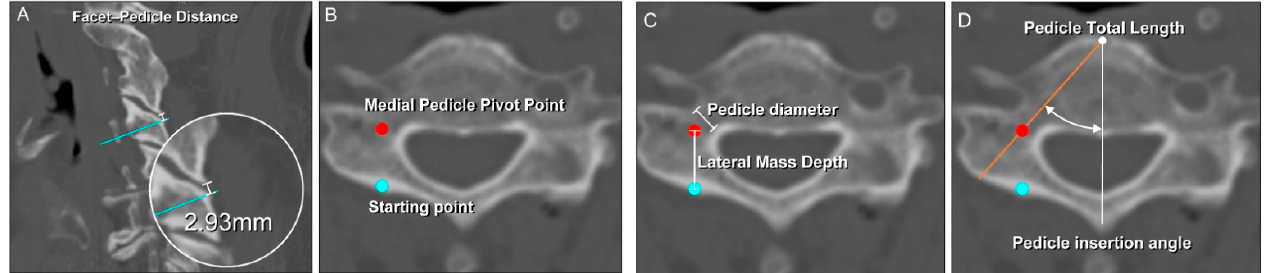
Figure 1. Sagittal and axial computed tomography images of the cervical spine illustrating the morphometric measurements and medial pedicle pivot point (MPPP). ( A ) The facet–pedicle distance was measured from the tip of the inferior articular process of the cephalad vertebra, to a point intersecting a line drawn through the center of the pedicle in the sagittal view (light blue line). ( B ) The red circle indicates the MPPP located at the correct point/center of the pedicle. The light blue circle indicates the starting point. ( C ) Pedicle diameter was measured as shown. The lateral mass depth was measured from the starting point at the dorsal border of the lateral mass, to the MPPP. ( D ) The pedicle insertion angle corresponded with the vertical angle of screw application, while the pedicle total length corresponded with the approximate maximum length of the screw that could be inserted into the pedicle.